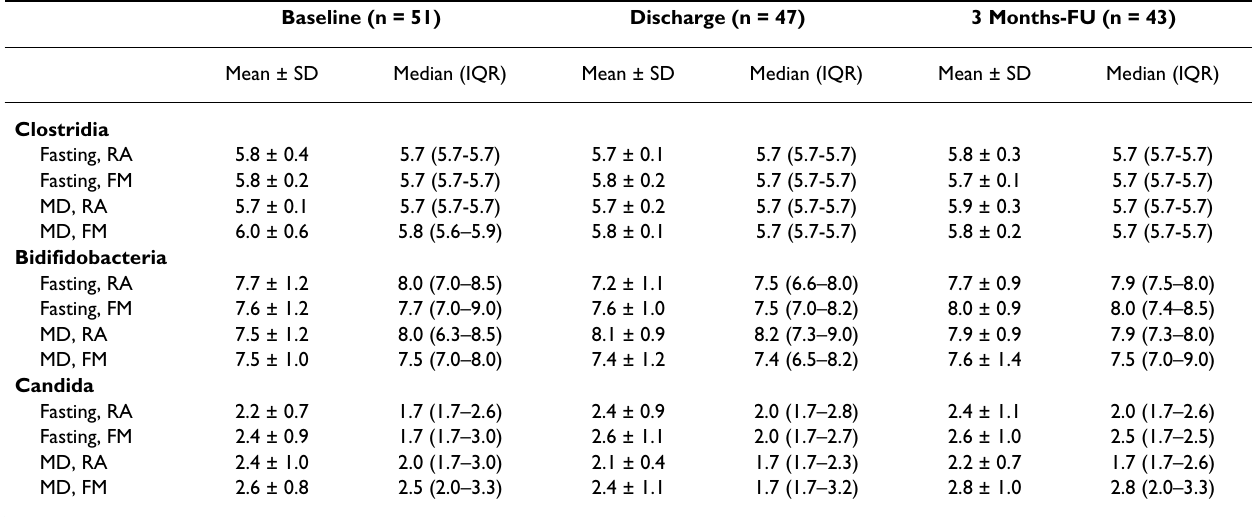
Table 3: Anaerob bacterial fecal flora and Candida log. numbers of characteristic bacteria at the three timepoints in the different groups. No statistically significant change between time points within and between